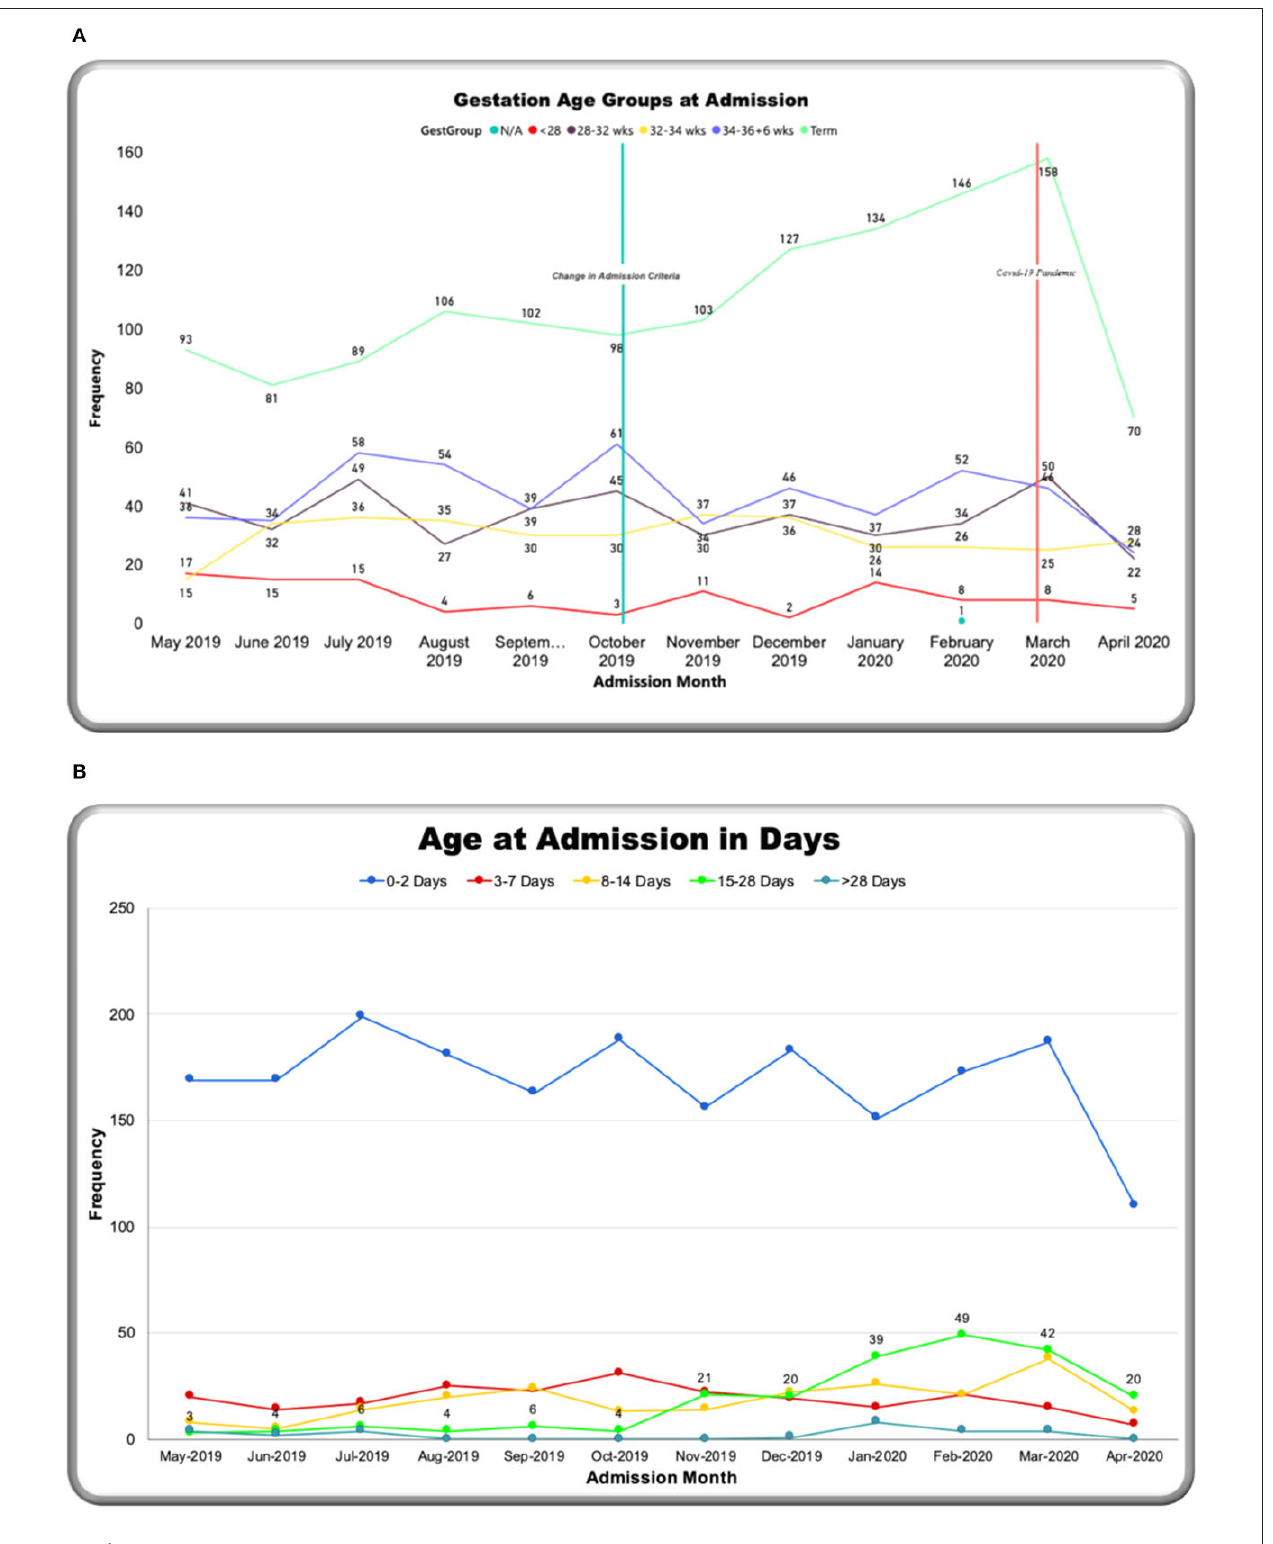
FIGURE 10 | M&M dashboard monthly trends: (A) Gestation, (B) age at admission in days.